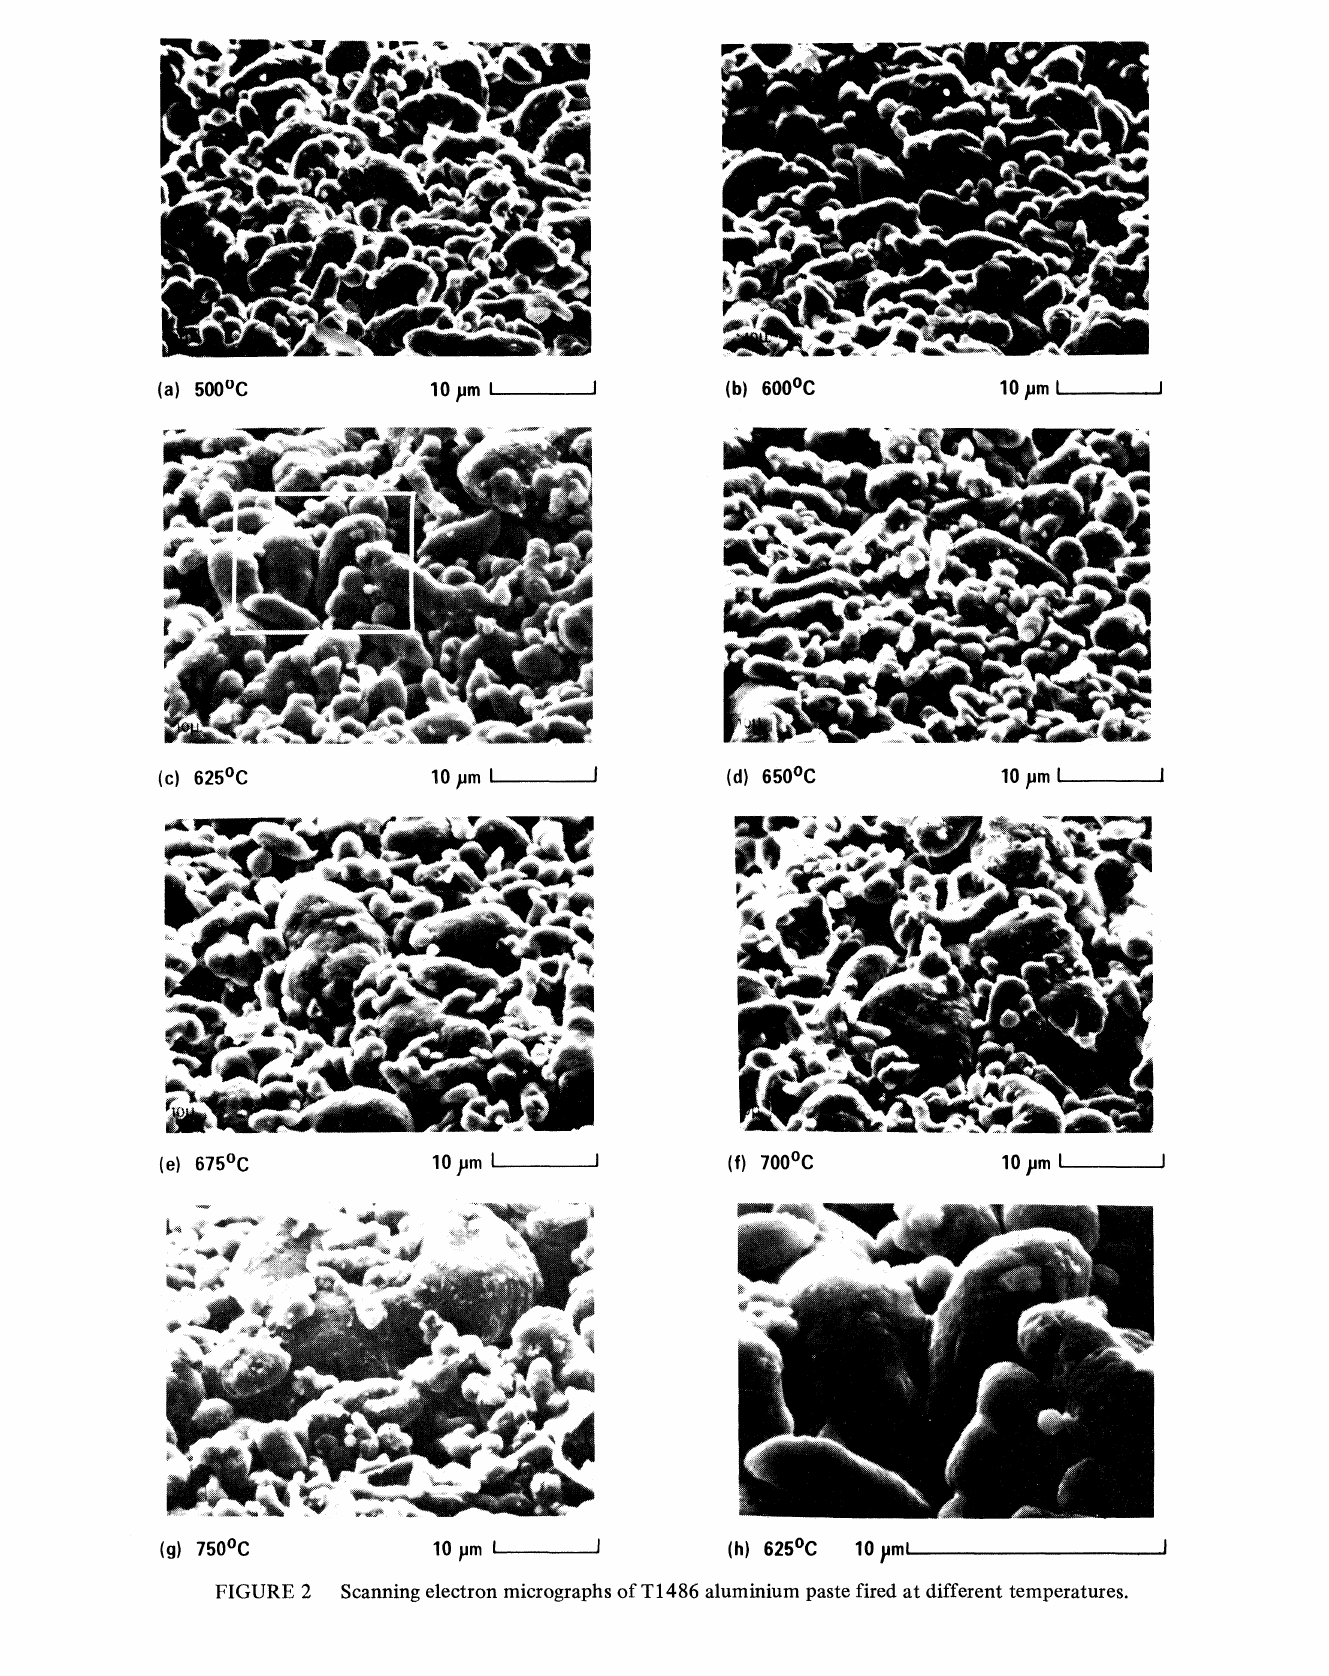
FIGURE 2 Scanning electron micrographs of T1486 aluminium paste fired at different